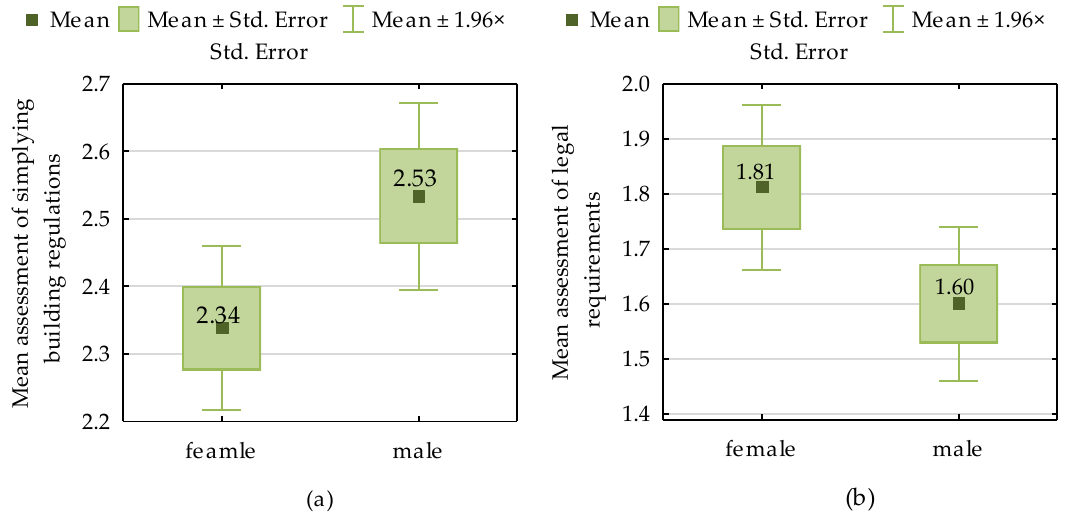
ulations simpler (mean assessment: 2.53 vs. 2.34) ( p = 0.0307). This was different for the legal males assessed this factor significantly more favourably than the males did (average as-